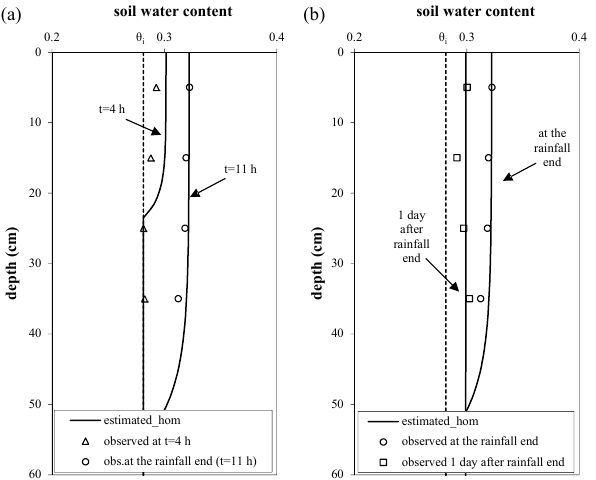
Fig. 4. Water content profiles simulated by the adopted models for homogeneous soil and sealed soil and specific values observed at different depths during different stages. Event 2 of Fig. 2 (see also Table 2). Saturated hydraulic conductivity of the parent soil 2mmh − 1 and seal layer 0.07mmh − 1 .